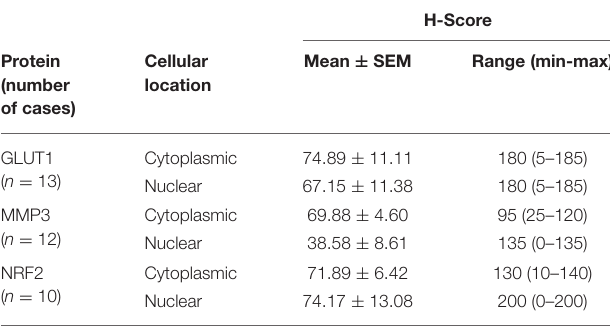
TABLE 1 | H-scores from GLUT1, MMP3 and NRF2 immunostained canine OSA specimens showing inter case